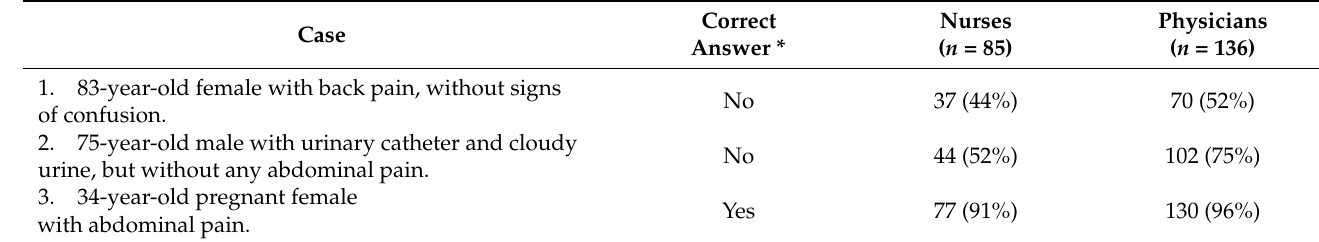
Table 3. Number of correct answers to patient